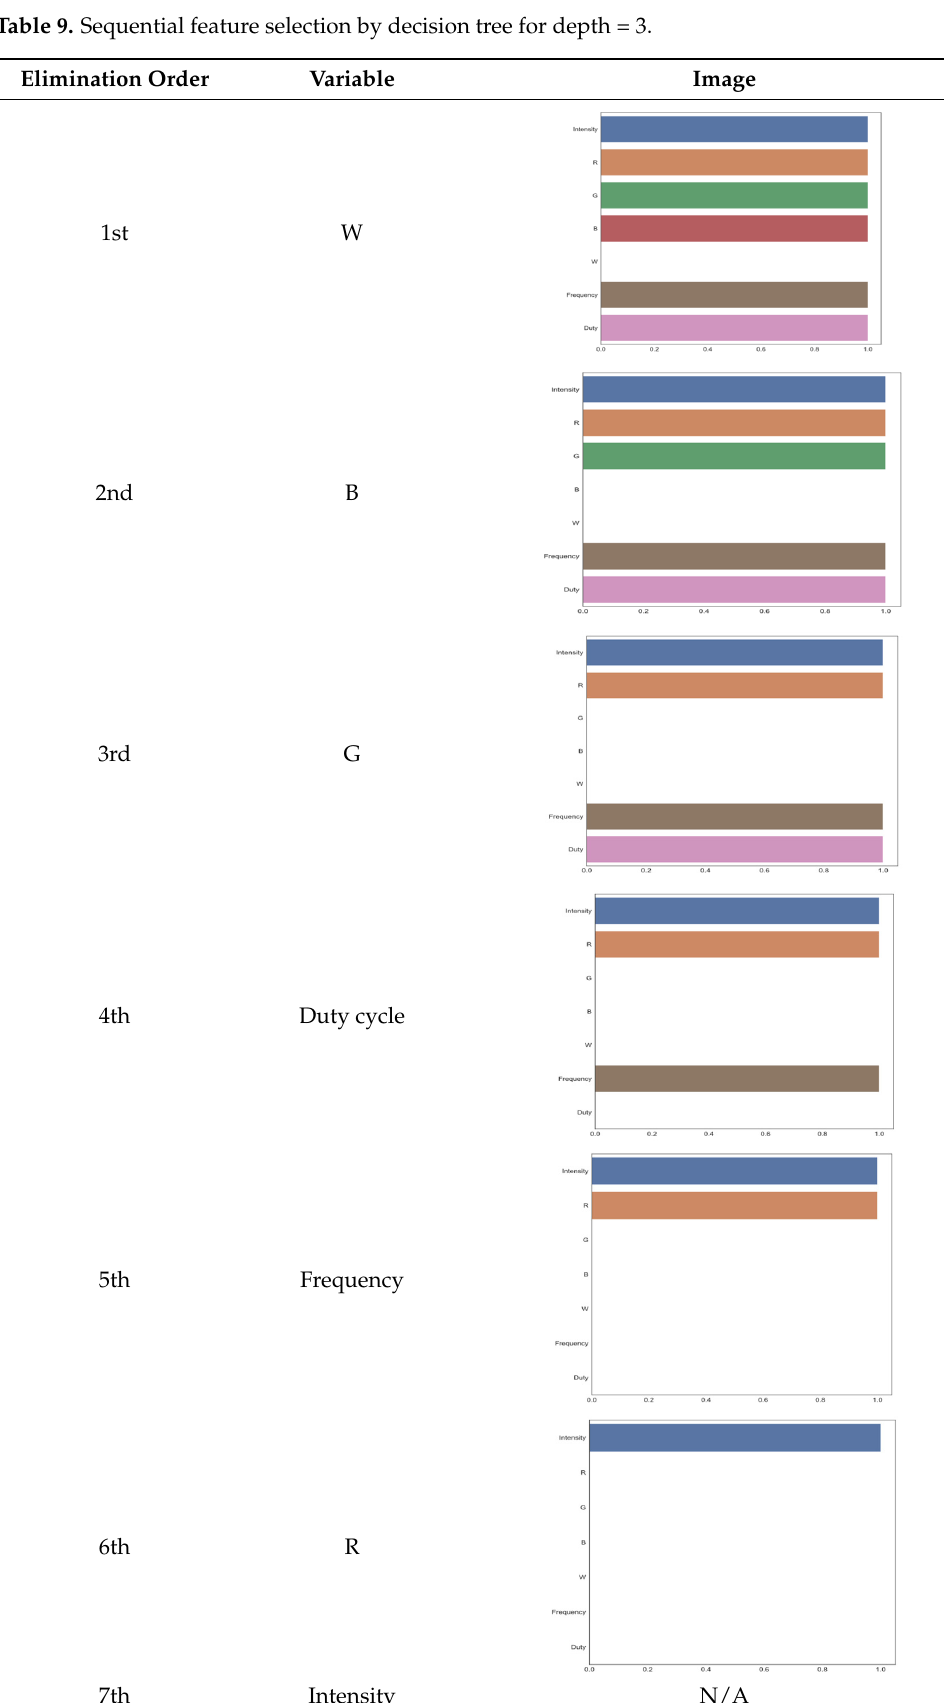
Table 9. Sequential feature selection by decision tree for depth = 3.